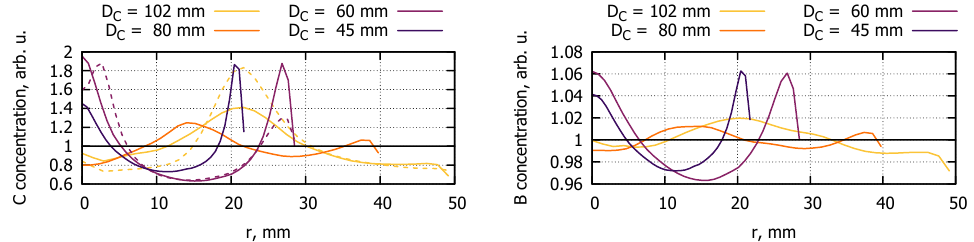
Figure 15. Normalized radial distributions of carbon ( left ) and boron ( right ) concentrations in the grown crystal (yellow line for the cylindrical phase, violet and orange lines for the cone phase), using crystal rotation rates 6 rpm (solid lines) and 12 rpm (dashed